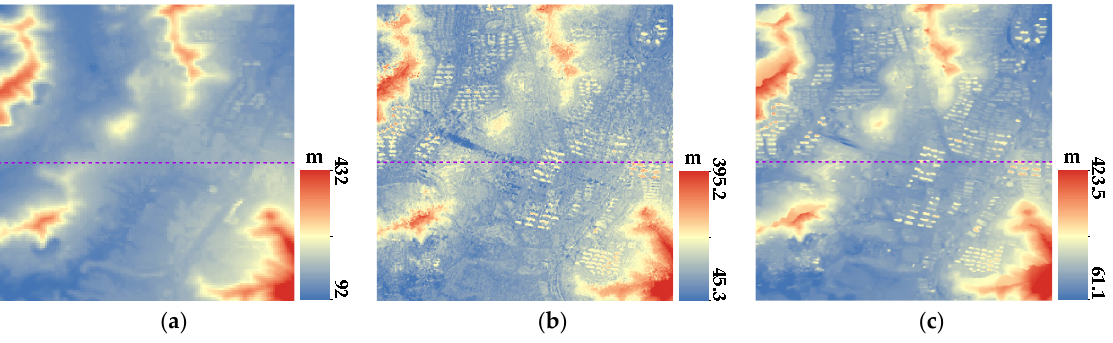
Figure 9. DSM of mountain peak regions: ( a ) Reference DEM of peak region 1; ( b ) DSM extracted by ENVI of peak region 1; ( c ) DSM of this paper of peak region 1; ( d ) Reference DEM of peak region 2; ( e ) DSM extracted by ENVI of peak region 2; ( f ) DSM of this paper of peak region 2; ( g ) Reference DEM of peak region 3; ( h ) DSM extracted by ENVI of peak region 3; ( i ) and DSM of this paper of peak region 3.